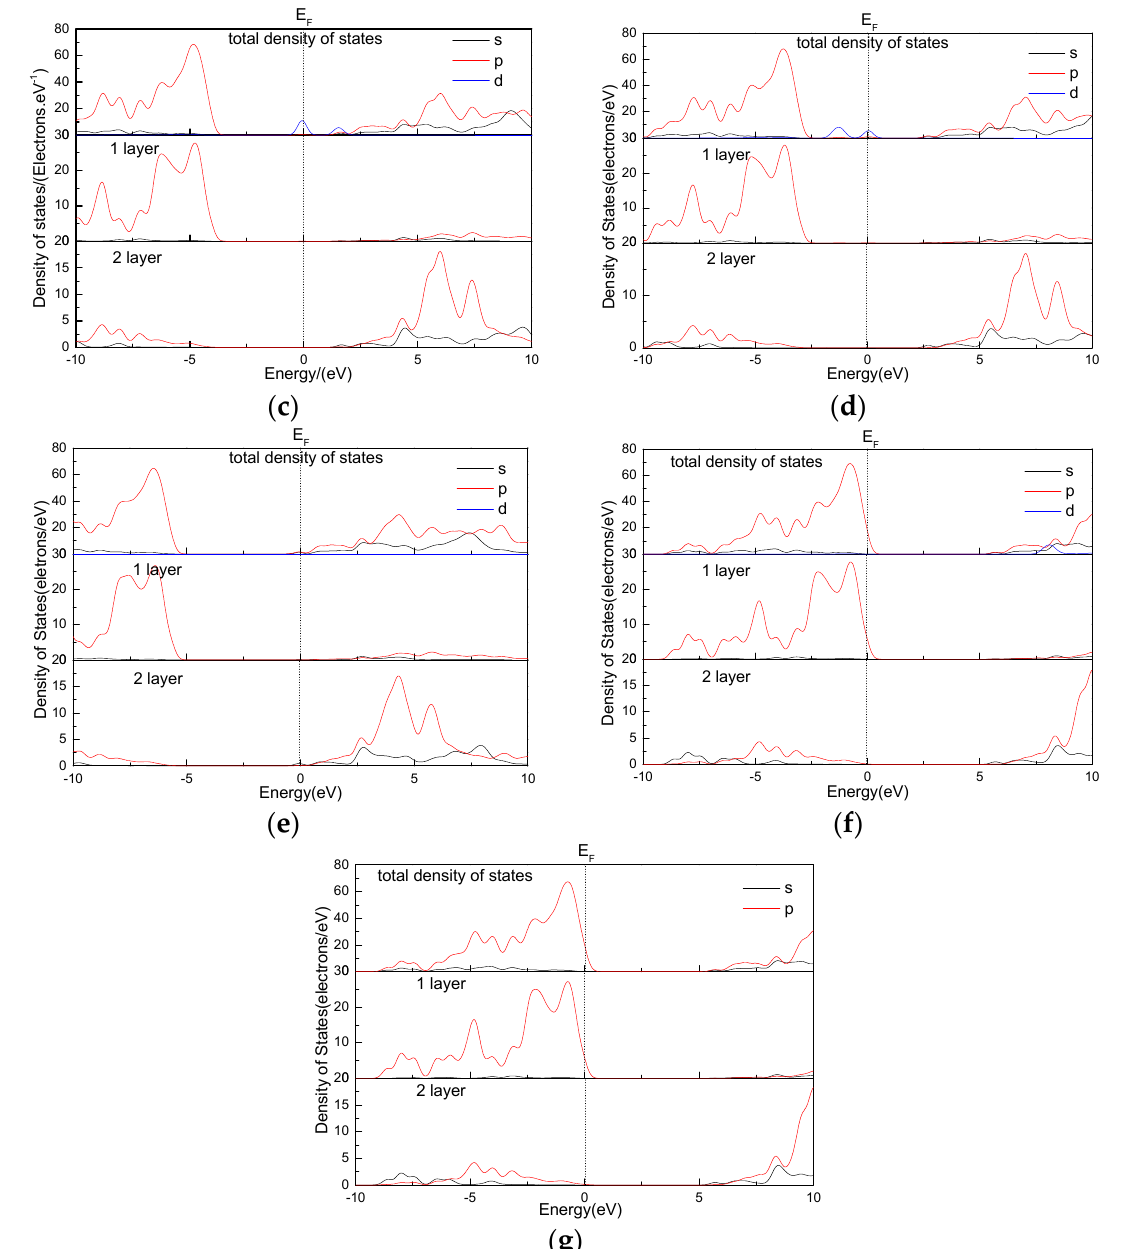
Figure 8. State density diagram of the ideal talc surface and the point defect surface: ( a ) ideal surface ( b ) Fe impurity defect surface, ( c ) Mn impurity defect surface, ( d ) Ni impurity defect surface, ( e ) Al impurity defect surface, ( f ) Ca impurity defect surface, and ( g ) Mg vacancy defect surface.